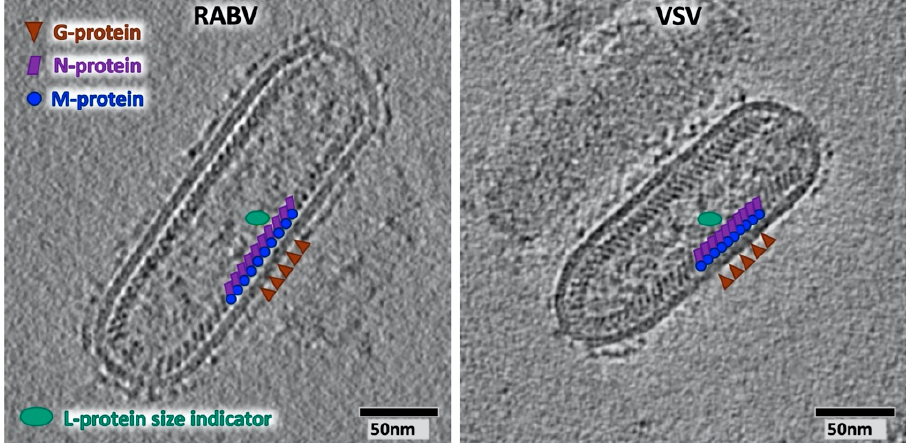
Figure 1. Cryo-electron tomograms of rabies virus (RABV) and vesicular stomatitis virus (VSV) particles at the same scale. The locations of the M- and N-proteins are indicated by blue circles and purple rectangles, respectively. The location of the G-protein is indicated by red triangles, and the size of the L-protein, as derived from the electron density map of the VSV L-protein generated by [6], is indicated in green. The tomograms were acquired on an FEI Glacios (ThermoFisher, OR, USA) with a Falcon2 (ThermoFisher, OR, USA) direct electron detector, reconstructed in etomo [7] and visualised by employing 3dmod [7].